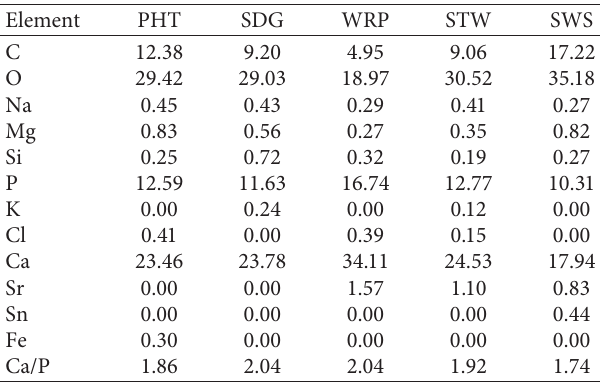
Table 3: Elemental mapping by weight% according to the ex- perimental